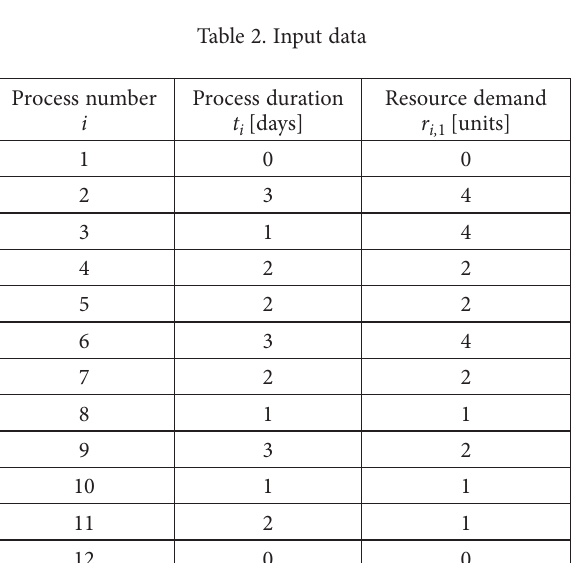
Figure 1. Project network